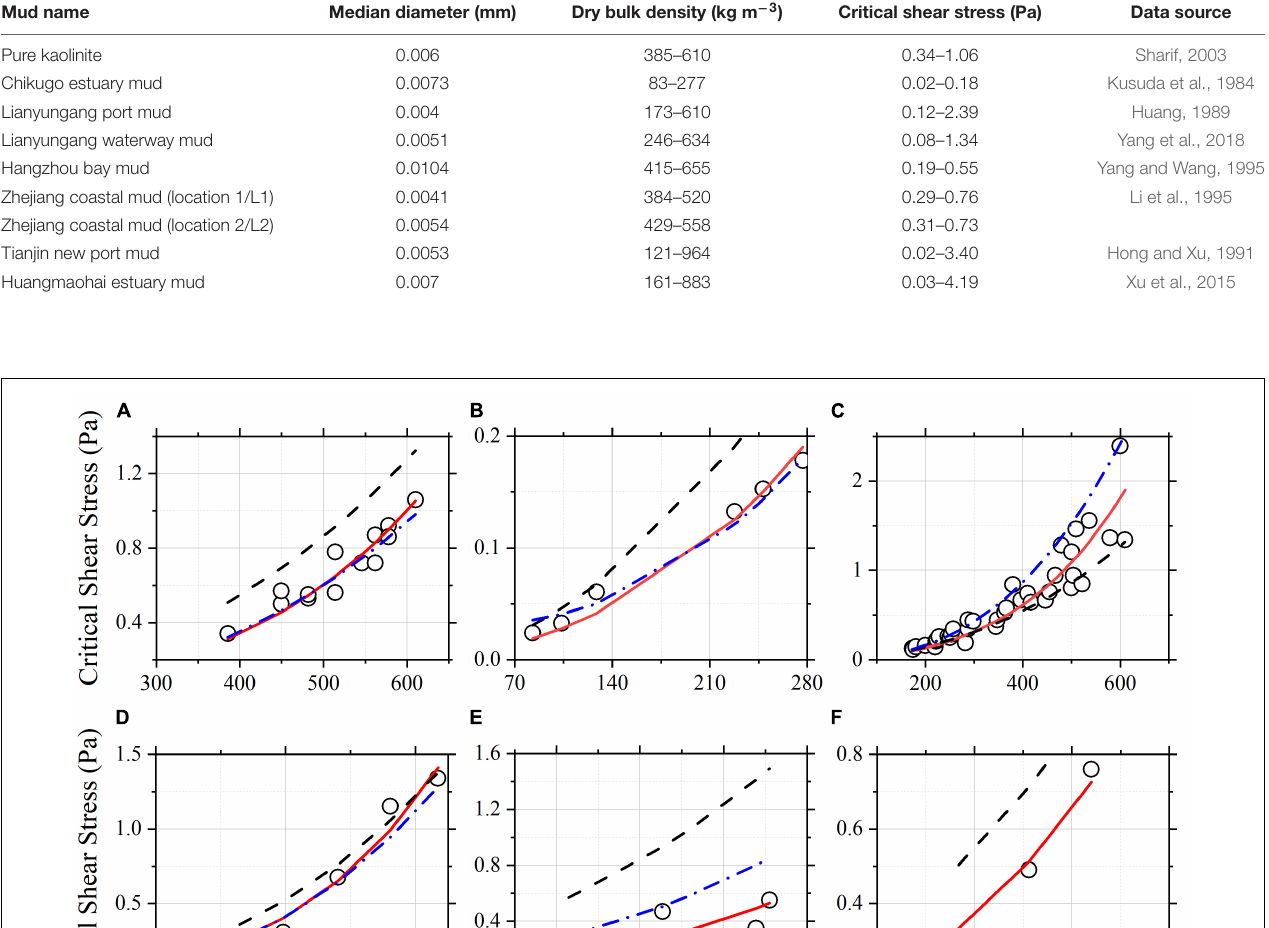
Frontiers in Marine Science |